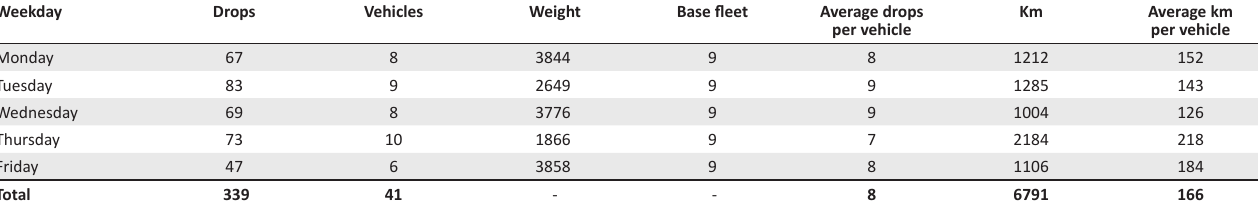
TABLE 4: Distribution centre 4 plan case study